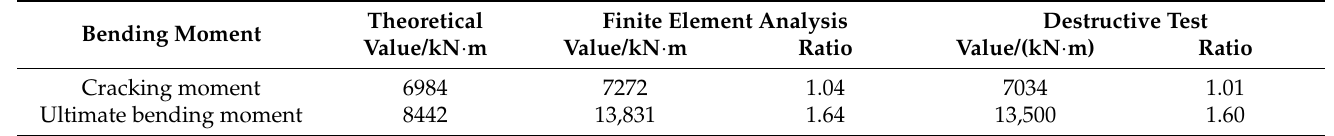
Table 7. Comparison of the experimental and predicted results of the undamaged box girder.